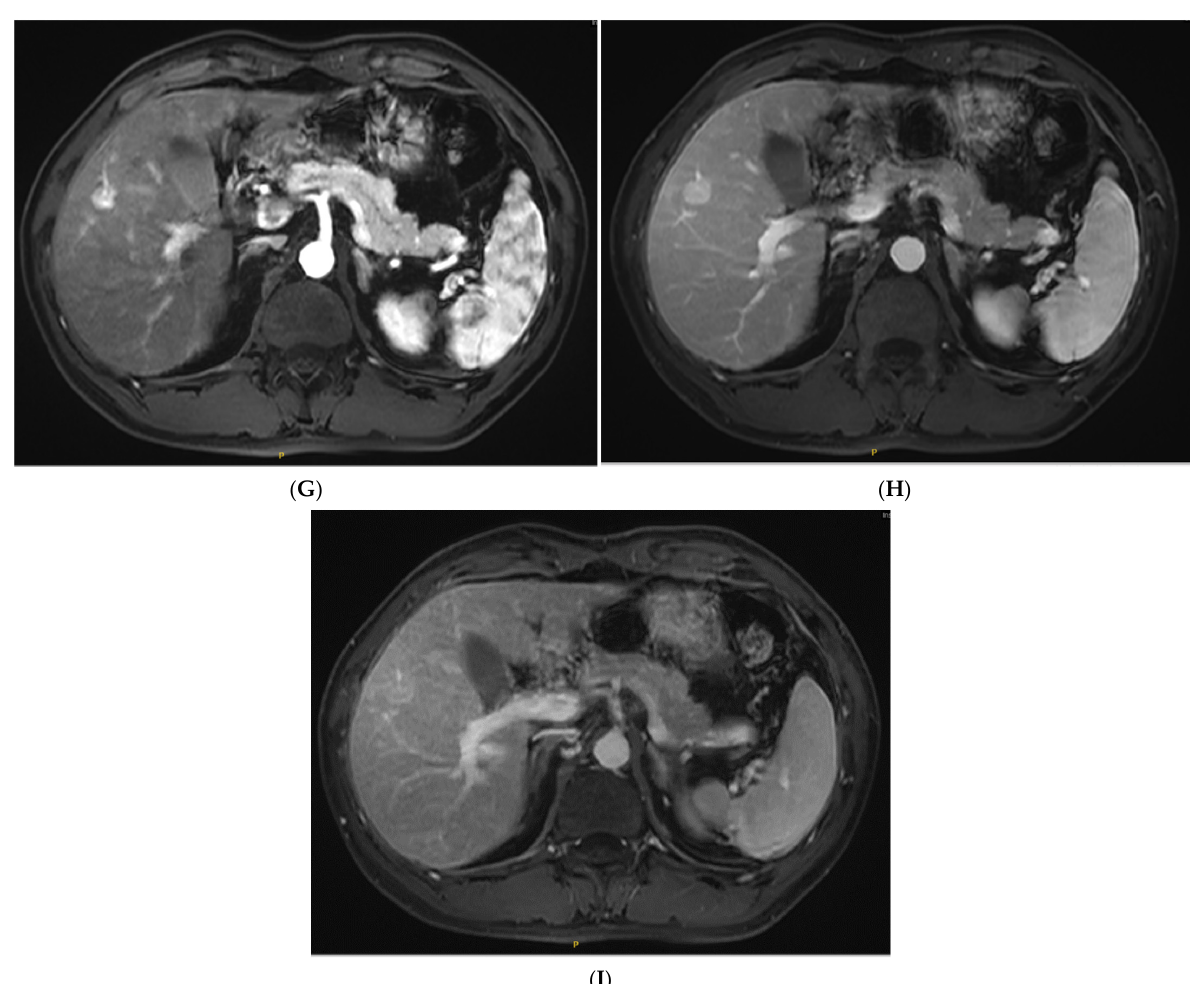
Figure 2. The contrast-enhanced images of non-steatohepatitic hepatocellular carcinoma (non-SH- HCC). A hypo-echoic lesion in the right lobe of the liver was seen as seen via BMUS ( A ). In the early arterial phase of CEUS, the hepatic nodule was homogeneously hyperenhanced ( B ). During, it pre- sented continuous iso-enhancement during the portal venous and late phase ( C , D ). On T1WI, the hepatic nodule was homogeneous hypointense ( E ). On T2WI, it was hypointense ( F ). As seen via contrast-enhanced scan, the lesion showed hyperintensity in the arterial phase ( G ). It exhibited slight hyperintensity in the portal venous phase ( H ). During the late phase, the hepatic lesion started to show iso-intensity ( I ).